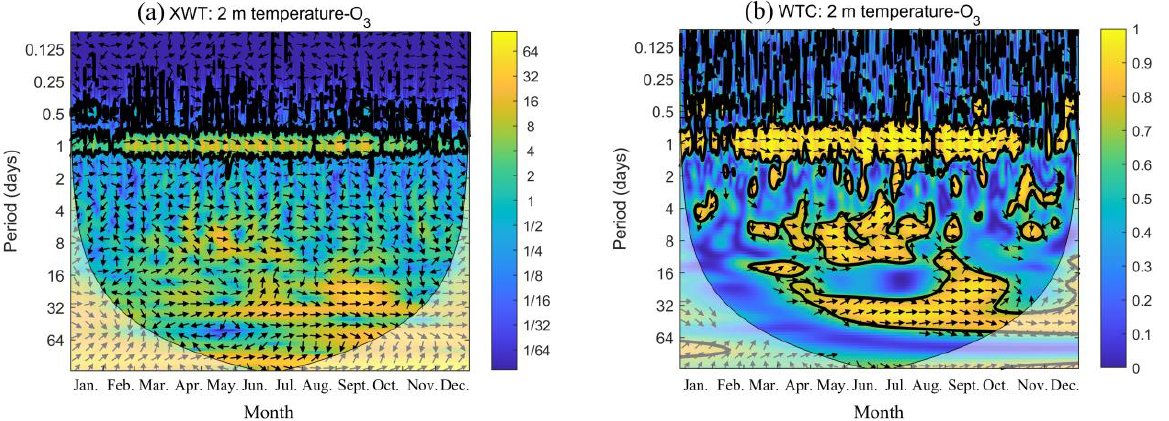
Figure 4. ( a ) Cross wavelet spectrum (XWT); ( b ) wavelet coherence spectrum (WTC) of 2 m temper- ature and O 3 .